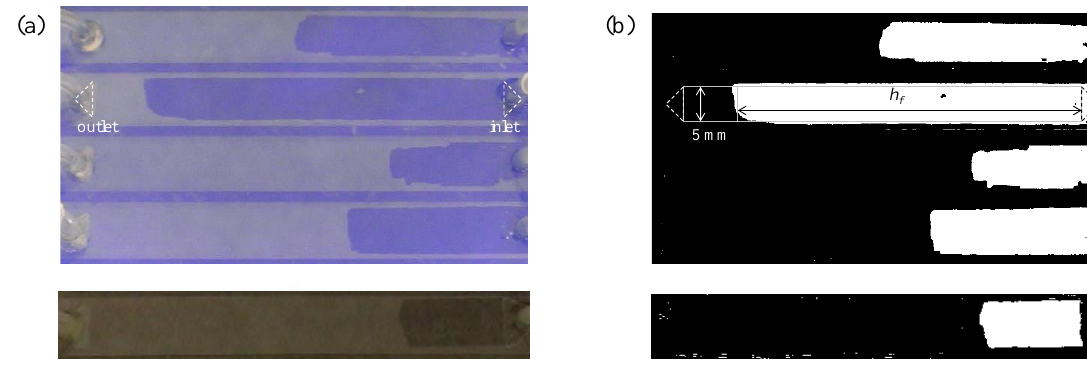
Fig. 4 Evaluation of wet length h . (a) Wet areas seen as dark regions gradually spread into dry channels from inlets. (b) f Pictures are converted into binary images in which wet regions are shown as white. Wet length is defined as distance between inlet and averaged front end of wetting.